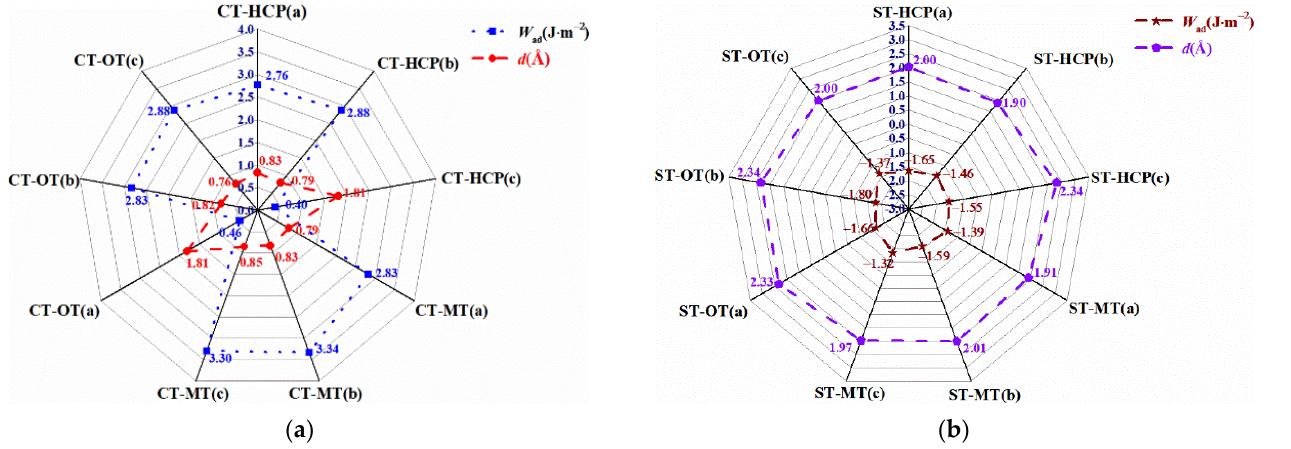
Figure 3. Interfacial distance and work of adhesions for 6H-SiC(0001)/Cu(111): ( a ) CT-6H- SiC(0001)/Cu(111) interfaces; ( b ) ST-6H-SiC(0001)/Cu(111)